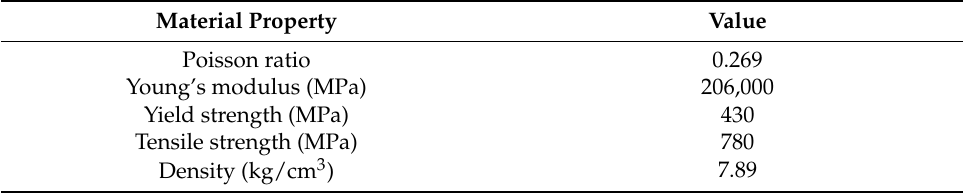
Figure 11. Length, velocity and acceleration curves in the 3RPS rotary part. ( a ) Length curve of each branched chain in 3RPS rotary part; ( b ) velocity curves of each branched chain in the 3RPS rotary part; ( c ) acceleration curves of each branched chain in the 3RPS rotary part. Table 3. Material parameters of tool steel